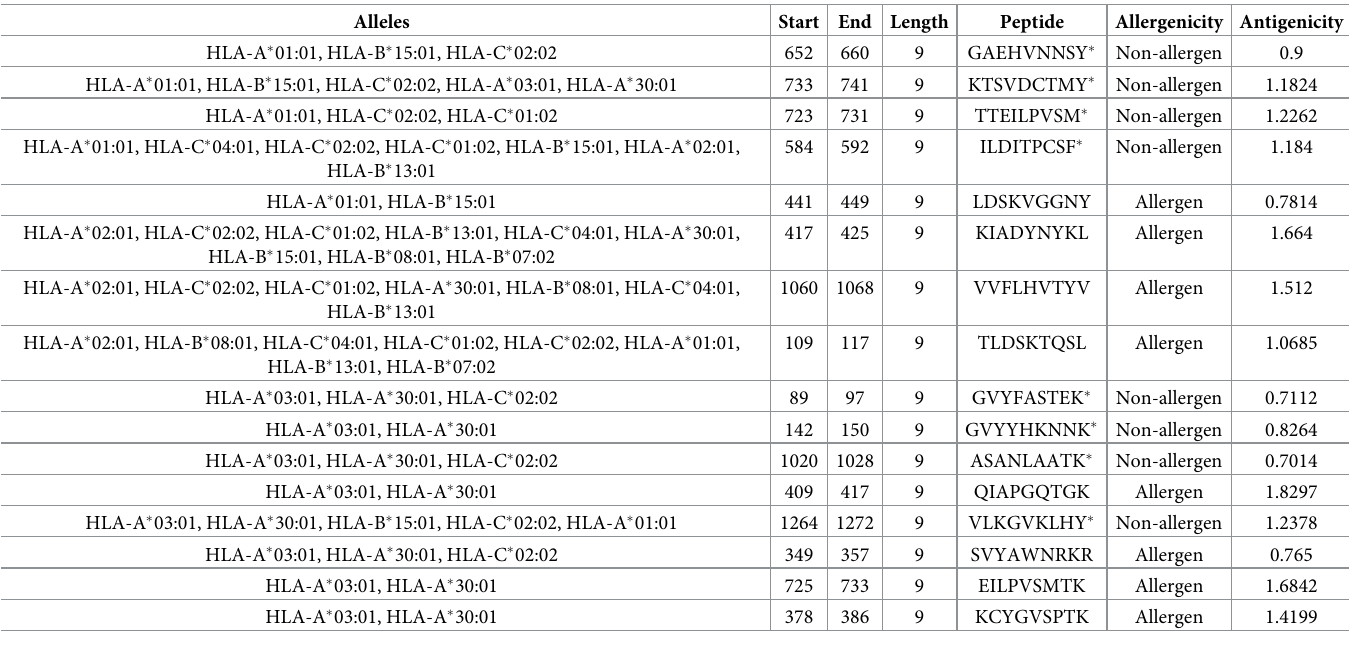
Table 3. MHC-I T cell epitopes of SARS-CoV-2 spike glycoprotein.